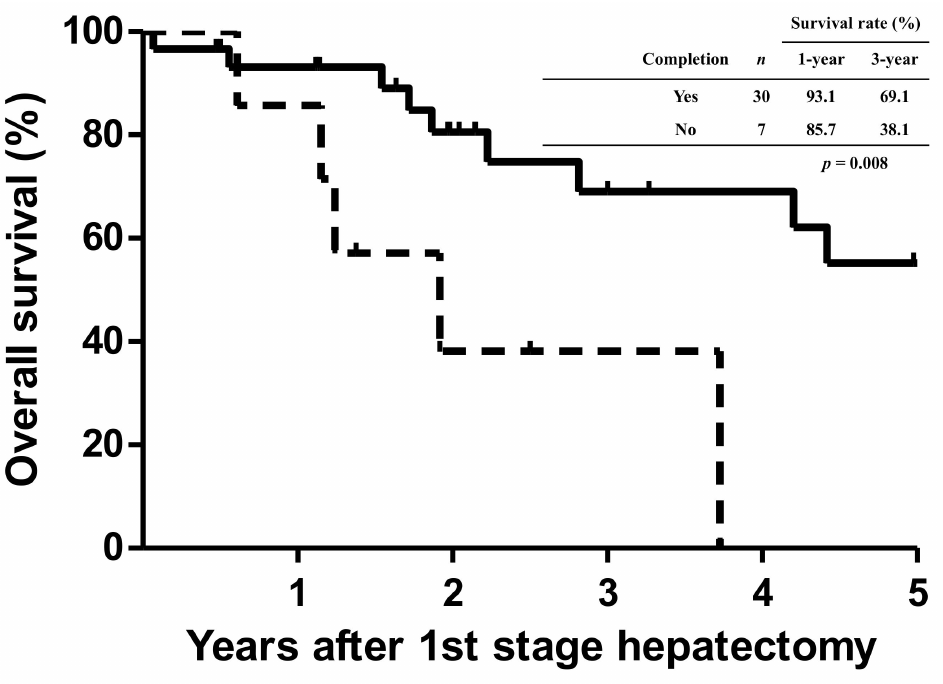
Figure 3. Kaplan–Meier cumulative survival curves for all patients based on the completion of staged hepatectomy. Patients who did not undergo complete staged hepatectomy had significant dismal outcomes when compared with those who completed the staged hepatectomy ( p =